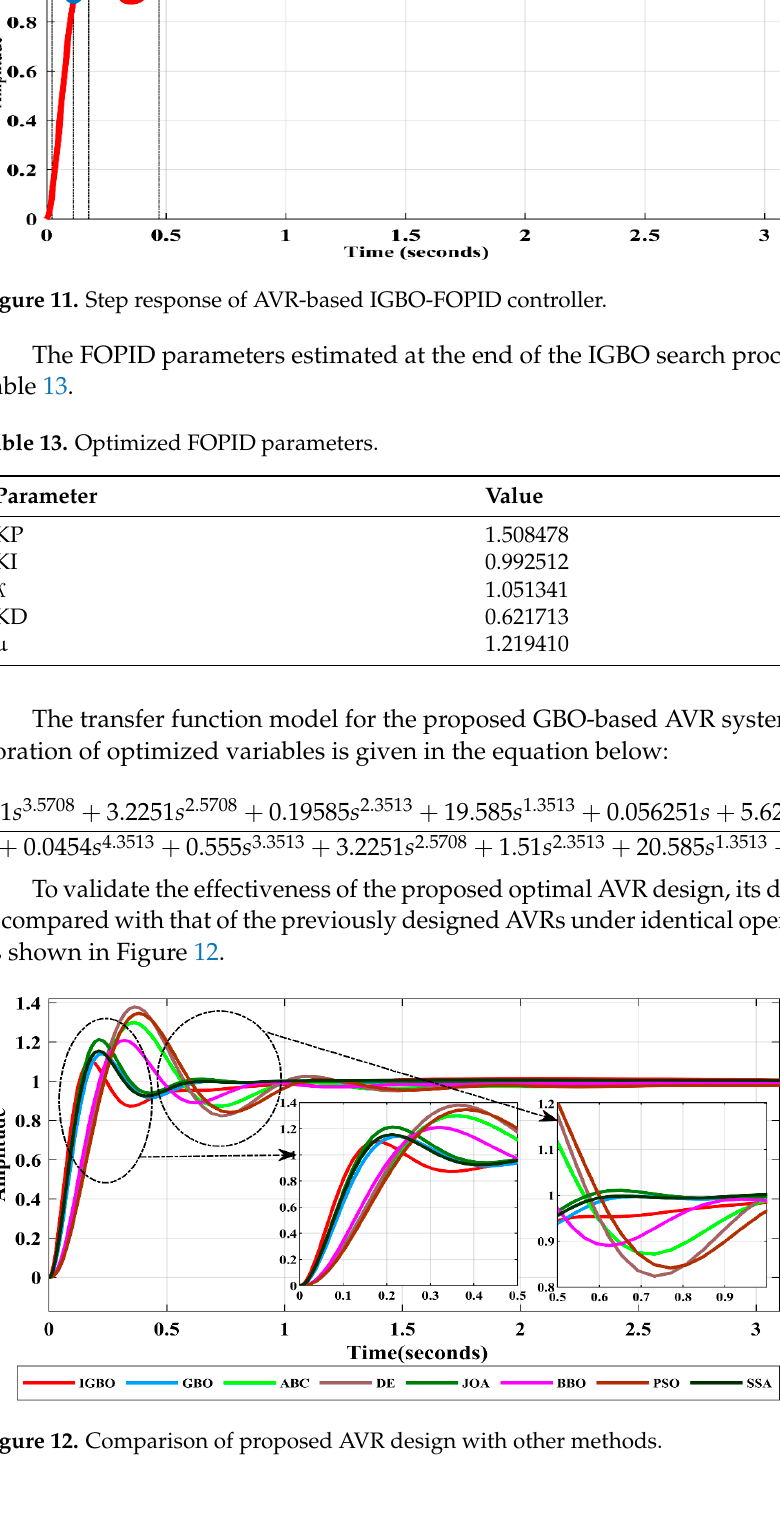
Table 14. Dynamic response evaluation of proposed GBO-based AVR design. PID/FOPID Tuning Method